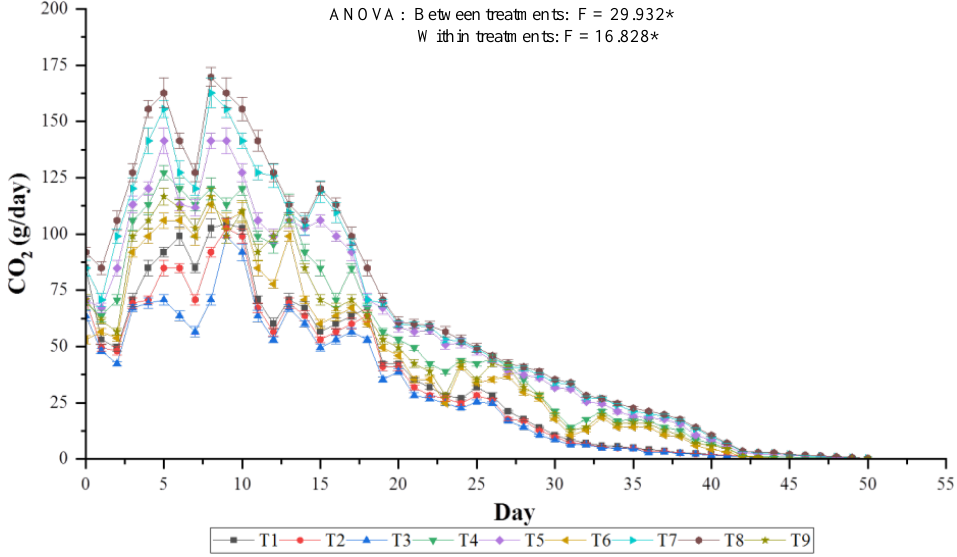
Figure 7. Profile of CO 2 emission (g/day) variations among different composting treatment groups.